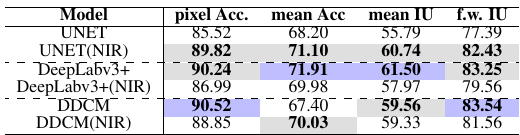
Table 4. Overall evaluation scores of models using RGB & NIR data. The best scores per column is highlighted in blue. The better score between the same model type is highlighted in